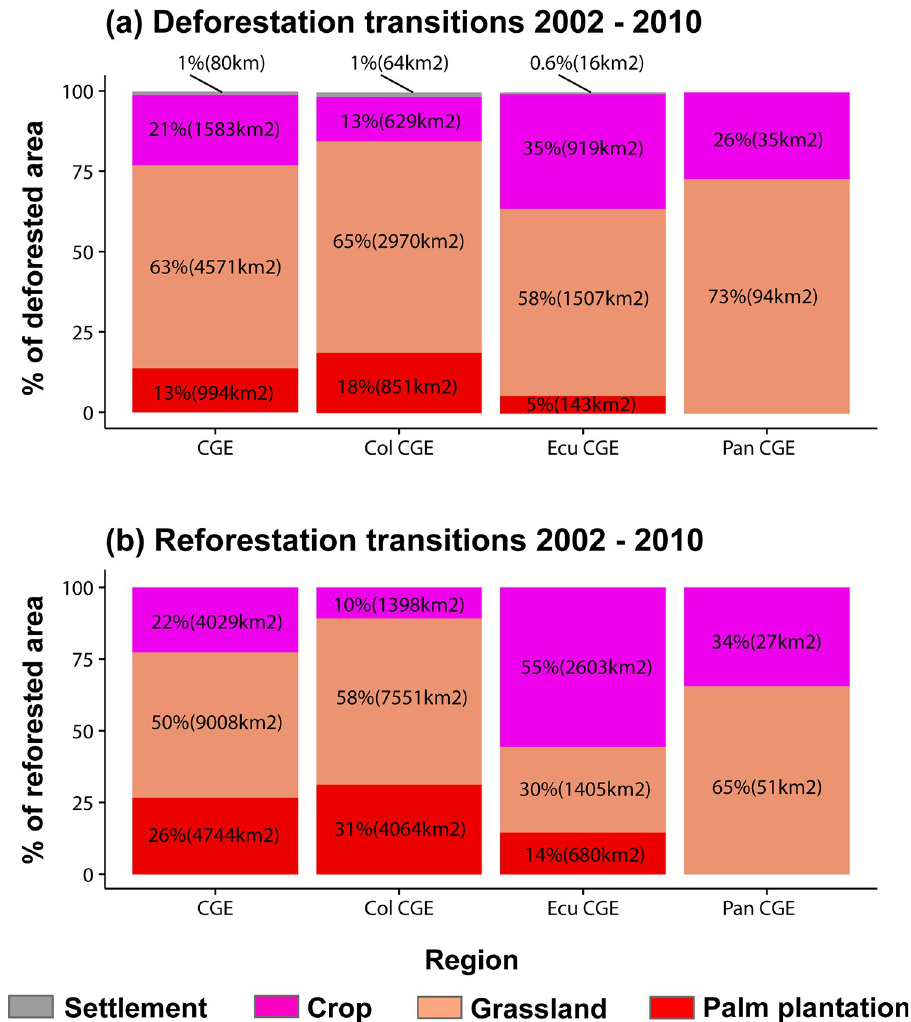
Fig 4. Quantification of deforestation (deforestation drivers) and reforestation transitions from 2002 to 2010. (a) Percentage of deforested area and net area deforested by every deforestation driver, and (b) percentage of reforested areas and net area reforested by every reforestation transition. The Choco´-Darien Global Ecoregion (CGE), Colombian CGE (Col CGE), Ecuadorian CGE (Ecu CGE), and Panamanian CGE (Pan CGE).